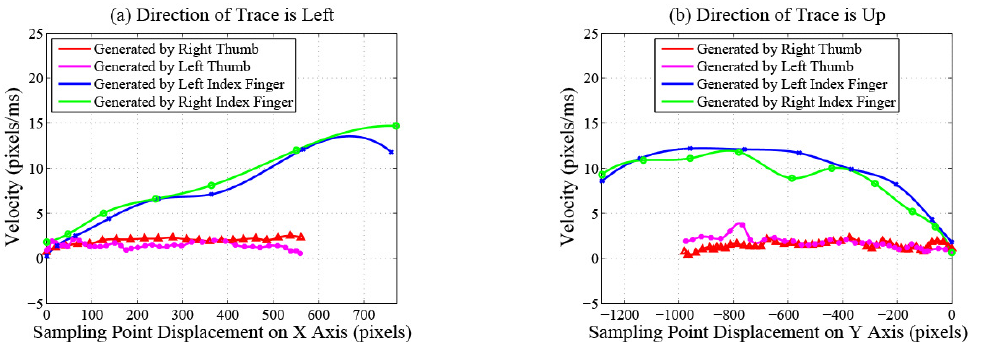
Figure 4. Velocity magnitude of each sampling